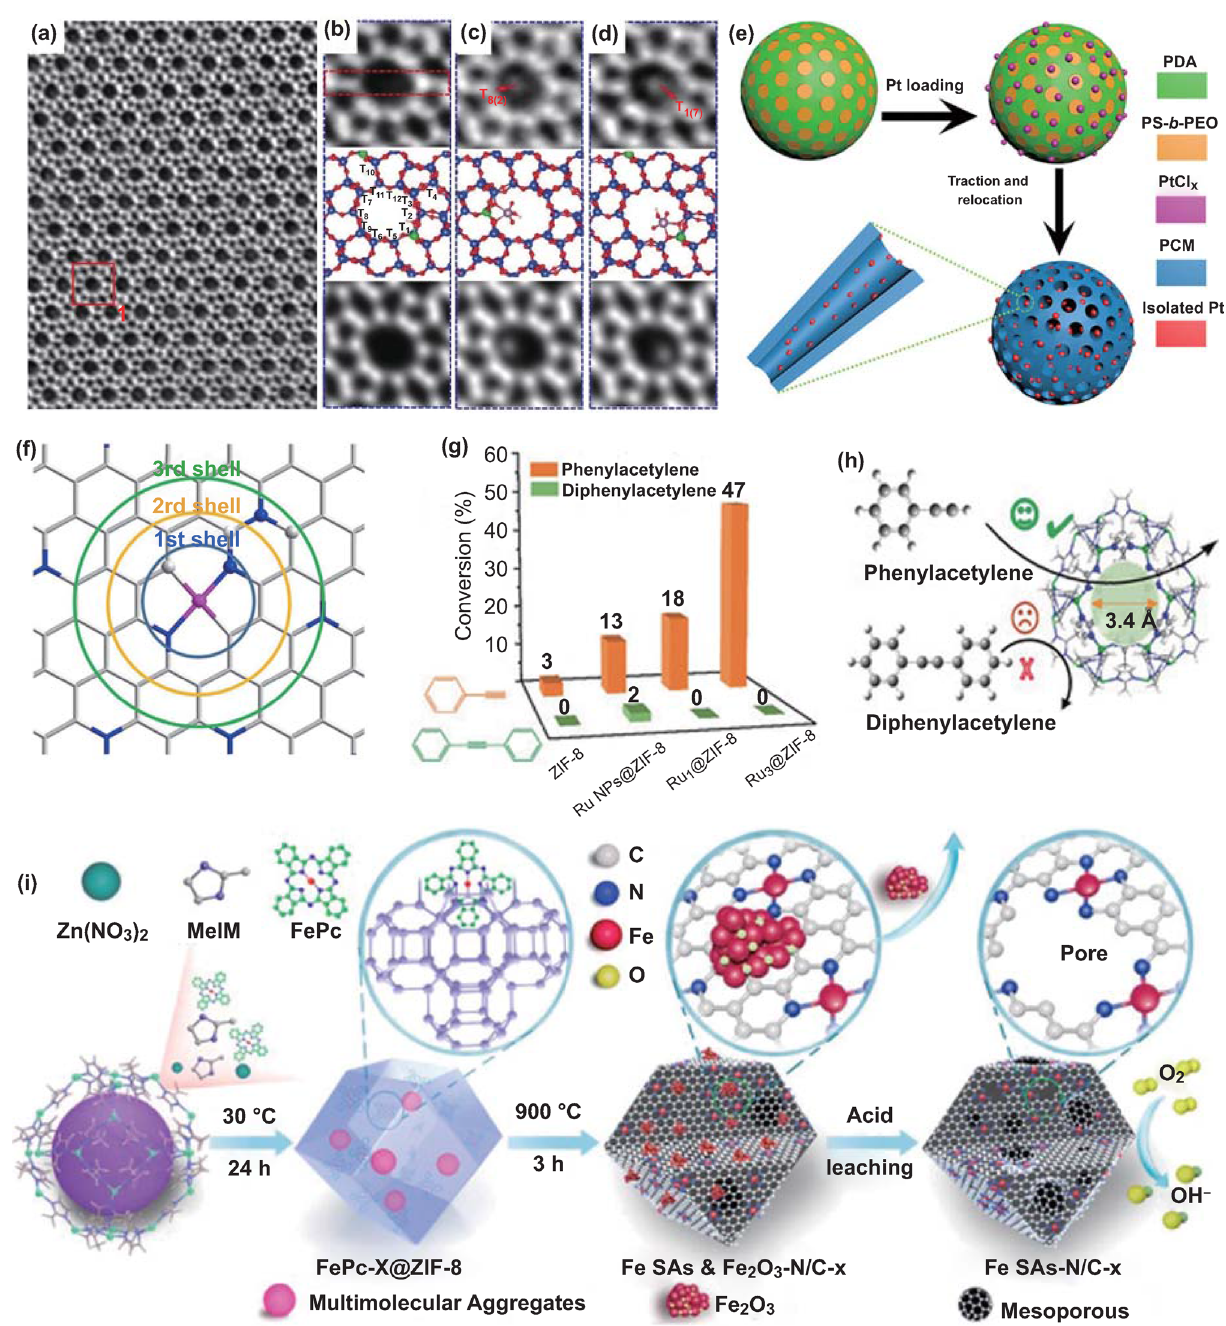
Fig. 5 a A representative iDPC-STEM image of Mo/ZSM-5, showing the presence of off-center contrast in many 10-MR channels. b–d Zoomed-in areas of a , corresponding to three scenarios: empty channel b , and channels containing a MoO 3 H cluster bound at the T8 site c and at the T1 site d . Each panel includes the raw image (top), the calculated structural model (middle), and the simulated projected electrostatic poten- tial (bottom). Si blue, O red, Al green, Mo pink, H white. a‑d Reproduced from Ref. [88] with permission. Copyright 2020 Wiley–VCH Verlag GmbH & Co. KGaA, Weinheim. e Schematic illustration of the synthetic procedure of Pt@PCM. f Schematic description for the coordination shells for the isolated Pt over the graphene. e–f Reproduced from Ref. [89] with permission. Copyright 2018, American Association for the Advancement of Science. g Conversion for hydrogenation of phenylacetylene over Ru 3 @ZIF-8, Ru 1 @ZIF-8 and references. h Molecular sieving size-selectivity sketch of phenylacetylene and diphenylacetylene. g–h Reproduced from Ref. [93] with permission. Copyright 2019 Wiley–VCH Verlag GmbH & Co. KGaA, Weinheim. i Schematic illustration of Fe-N 4 sites anchored on 3D hierarchically porous carbon. Reproduced from Ref. [94] with permission. Copyright 2018 American Chemical